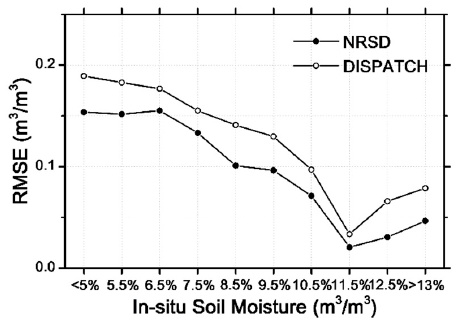
Figure 10. Error analysis in various drought conditions. Five-point-five percent represents that all disaggregated soil moistures with in situ measurements from 5% to 6% were considered, and the rest can be done in the same manner.